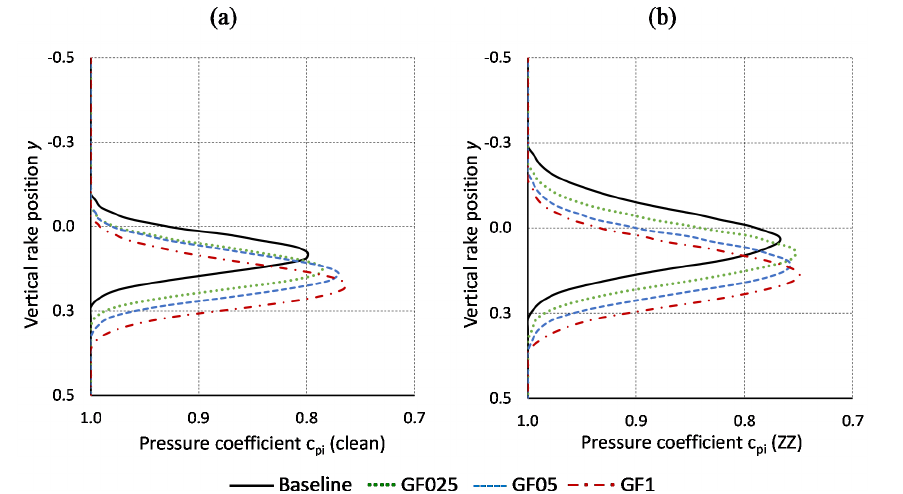
Figure 9. NACA63(3)618 at α = 6 . 4 ◦ . Gurney flaps. Pressure coefficients over vertical wake rake positions. (a) Clean case. (b) Tripped case.